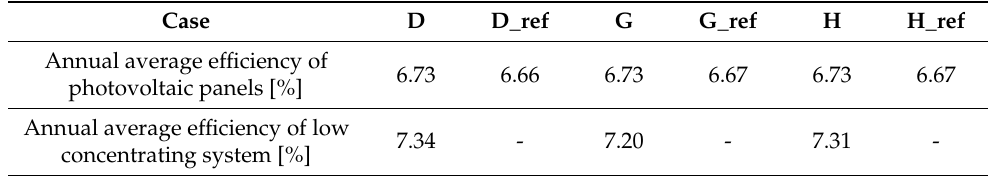
Table 10. Average annual